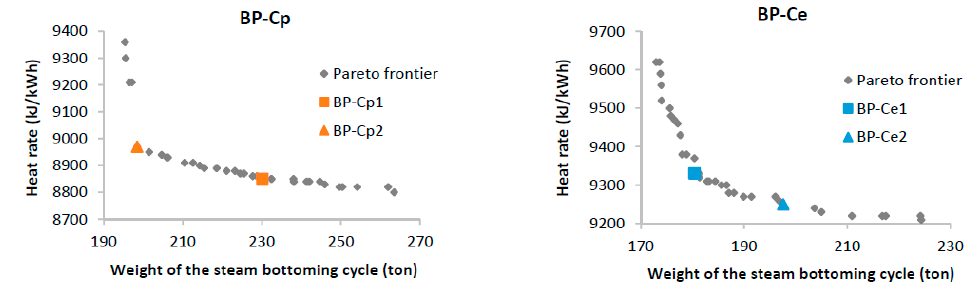
Figure A3. Pareto frontiers of backpressure steam turbine cycle for case C at peak (BP-Cp) and end-life (BP-Ce) conditions.